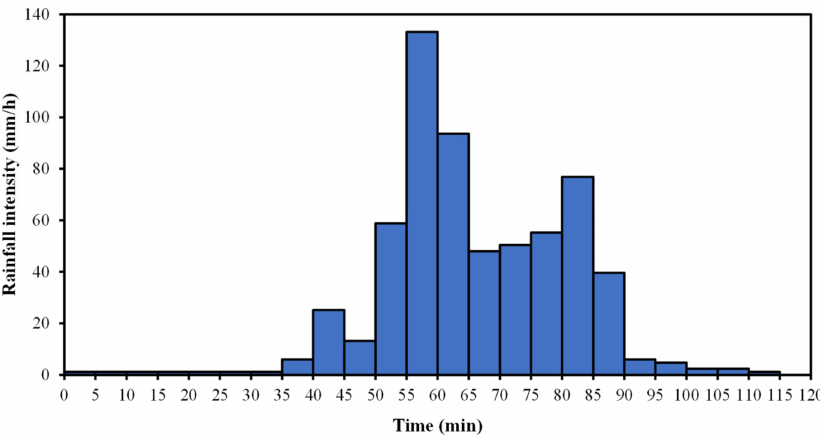
Figure A3. Rainfall hyetograph of 2-h duration for Kampung Melayu Subang Station (No.